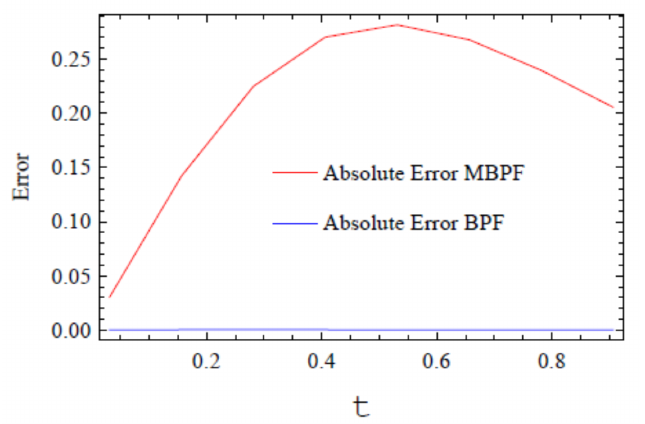
Figure 6. The absolute error of IBPFs and BPFs expansions comparison at the midpoints of the intervals of IBPFs.